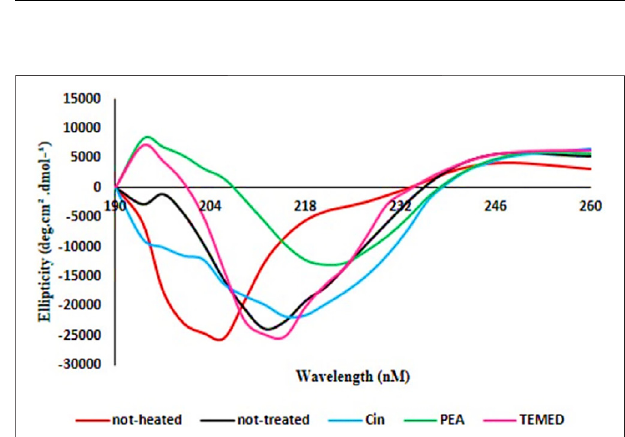
FIGURE7| Far-UVCDspectraoftauproteinincubatedwithandwithout the volatile compounds Cin, PEA, and TEMED. The CD spectra of not-heated tau protein compared to tau protein incubated in the presence or absence of volatile compounds Cin, PEA and TEMED are shown.